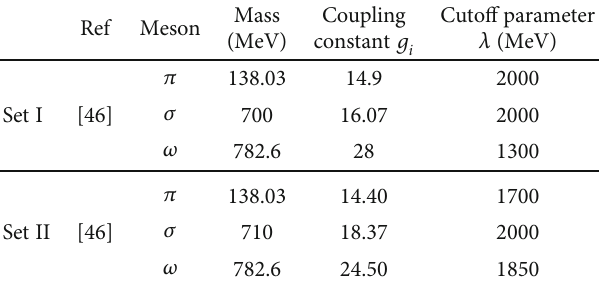
Table 1: The meson parameters for OBEP for di ff erent